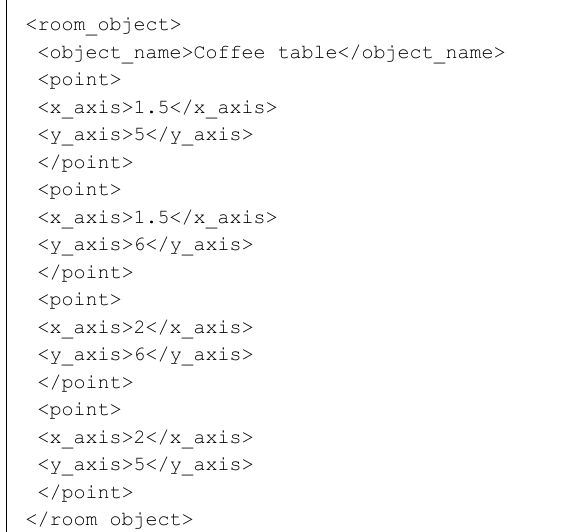
Figure 6. XML file containing information about objects in the